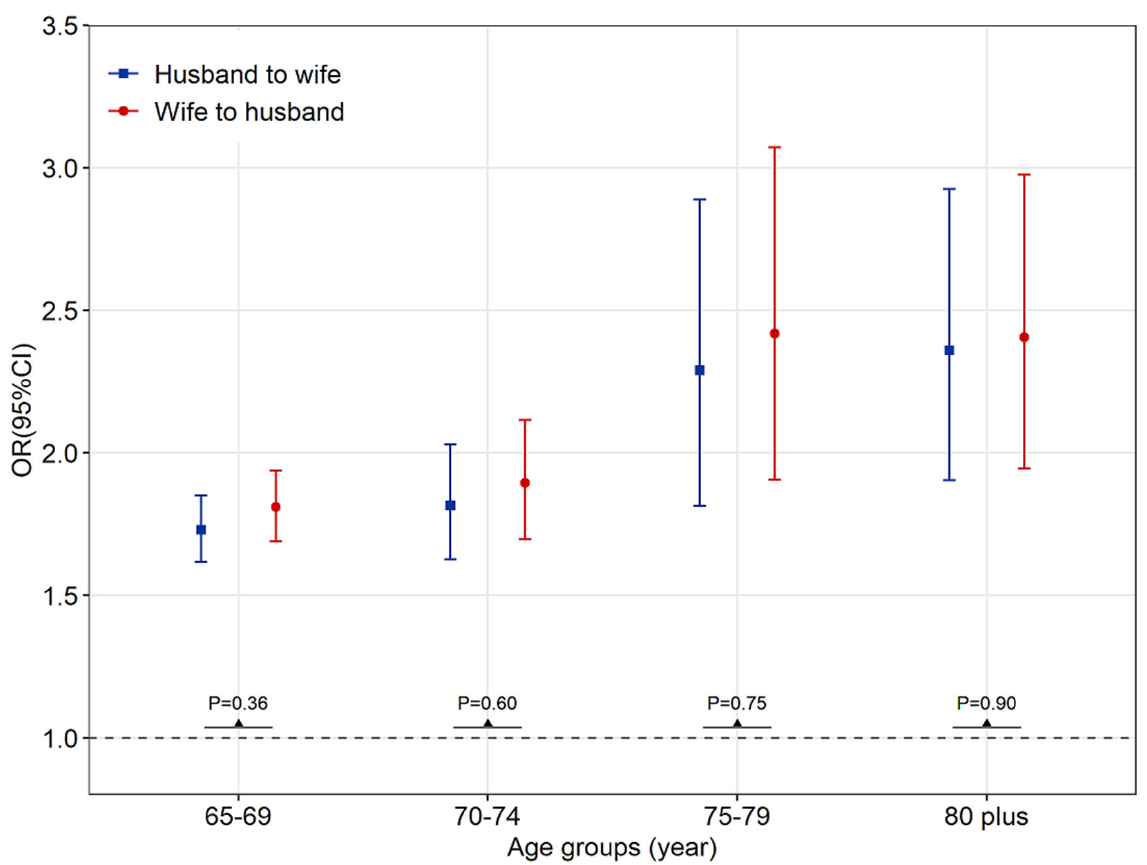
Figure 1. Reciprocal NAFLD association by gender among different age groups for the period 2018– 2020. Note: p -value for gender interaction. Abbreviations: OR: odds ratio; CI: confidence intervals.